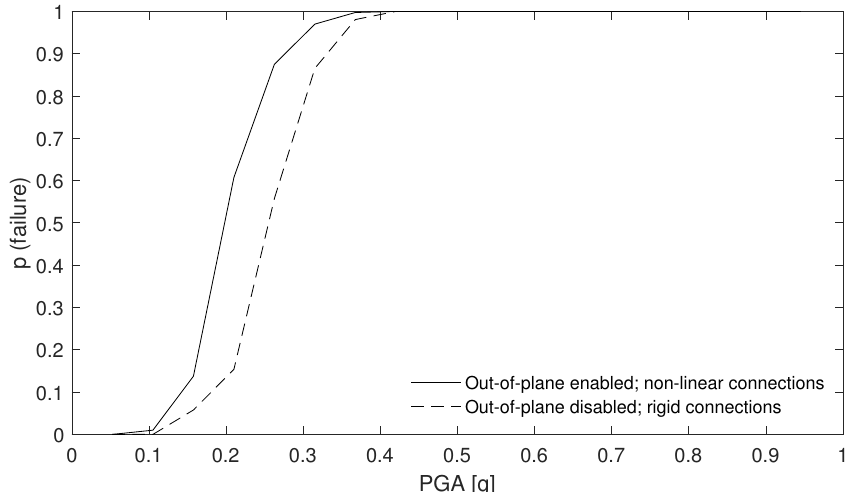
Figure 27. Comparison of Lausanne Malley fragility curves for models with: (i) out-of-plane enabled and non-linear connections, and (ii) out-of-plane disabled and rigid